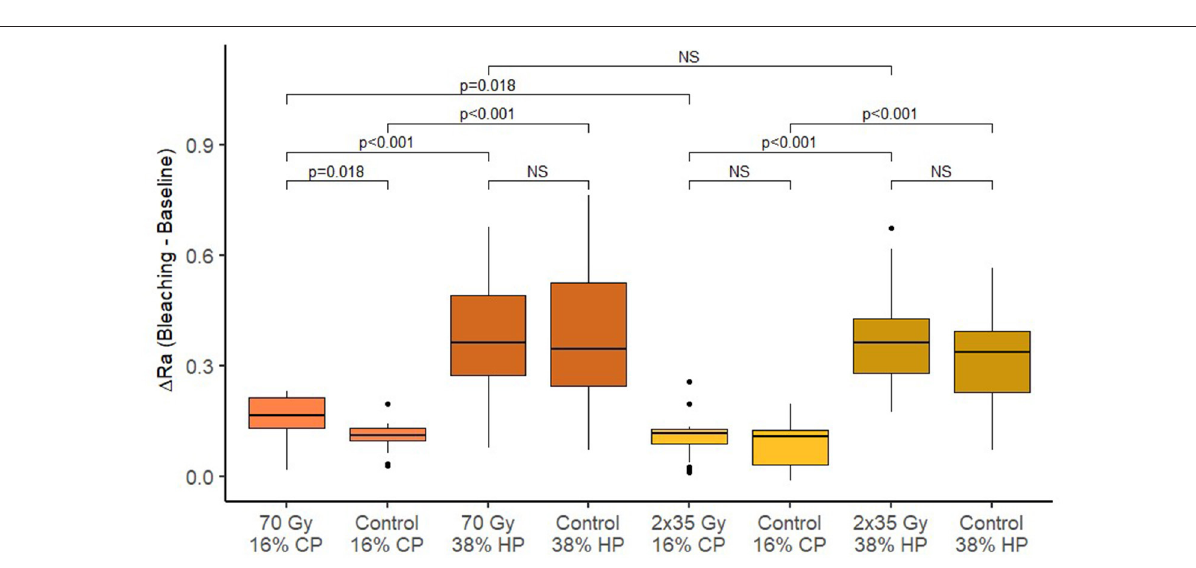
FIGURE 6 | Box-plots of changes in dentin roughness after bleaching across different treatment